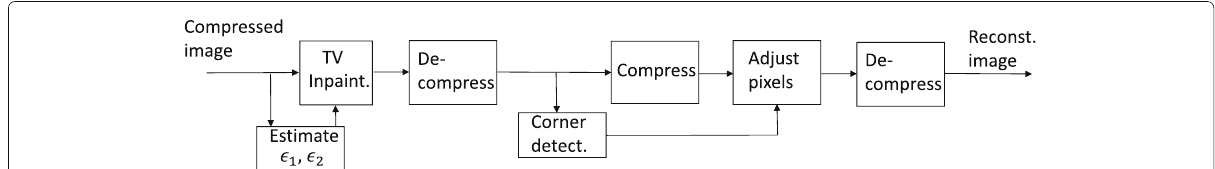
Fig. 3 Block diagram for spatial inpainting of single pixel errors in compressed frames